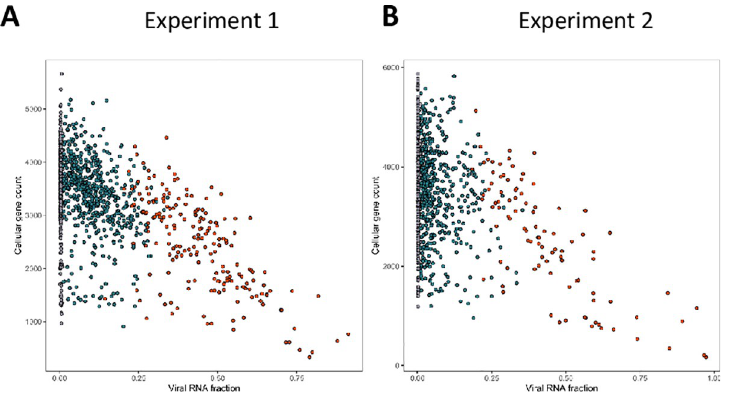
Fig 2. Correlation of cellular and viral genes expression measured by single-cell RNA sequencing. Cells from two independent TNBC were either mock infected or infected with VV (MOI = 5). Six hours later the cells were subjected to the 10X Genomics single-cell protocol, followed by sequencing. Dots represent cells positioned according to the percentage of viral gene expression (x-axis) and the number of cellular genes expressed (y-axis). Black dots represent mock infected cells, blue dots cells expressing early viral genes and red dots cells expressing early and late viral genes. A: experiment 1; B: experiment 2. Details of the samples used to obtain these data are listed in S1 Table.